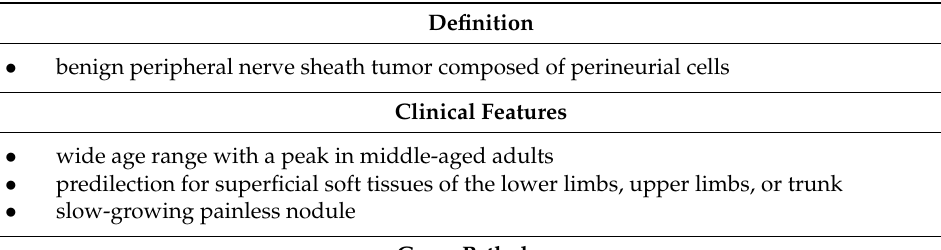
Table 14. Key diagnostic features of soft tissue